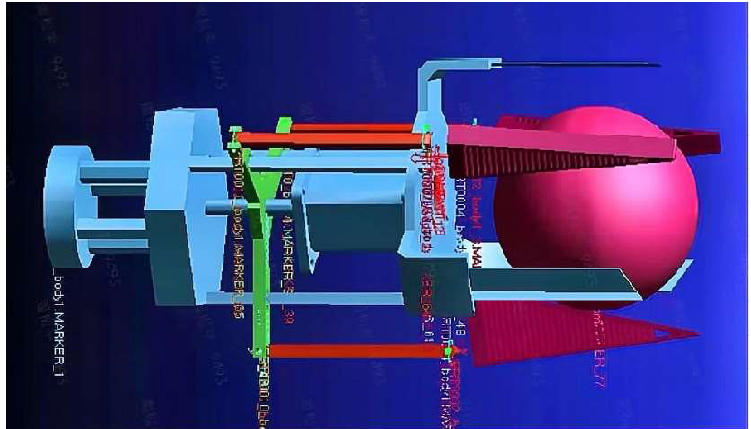
Figure 7. End-effector model in ADAMS.